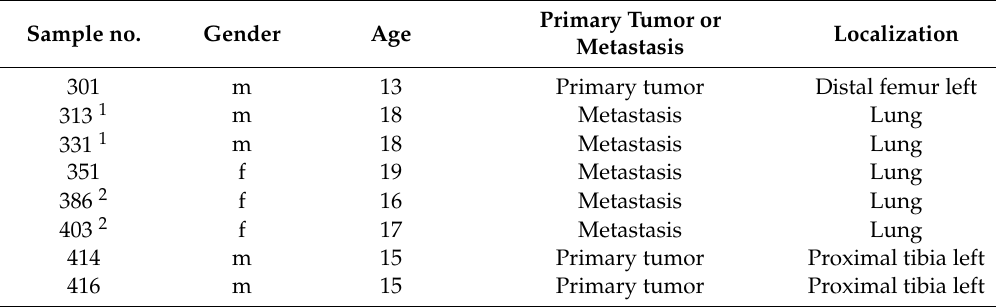
Table 1. Osteosarcoma (OS) primary cells used in the